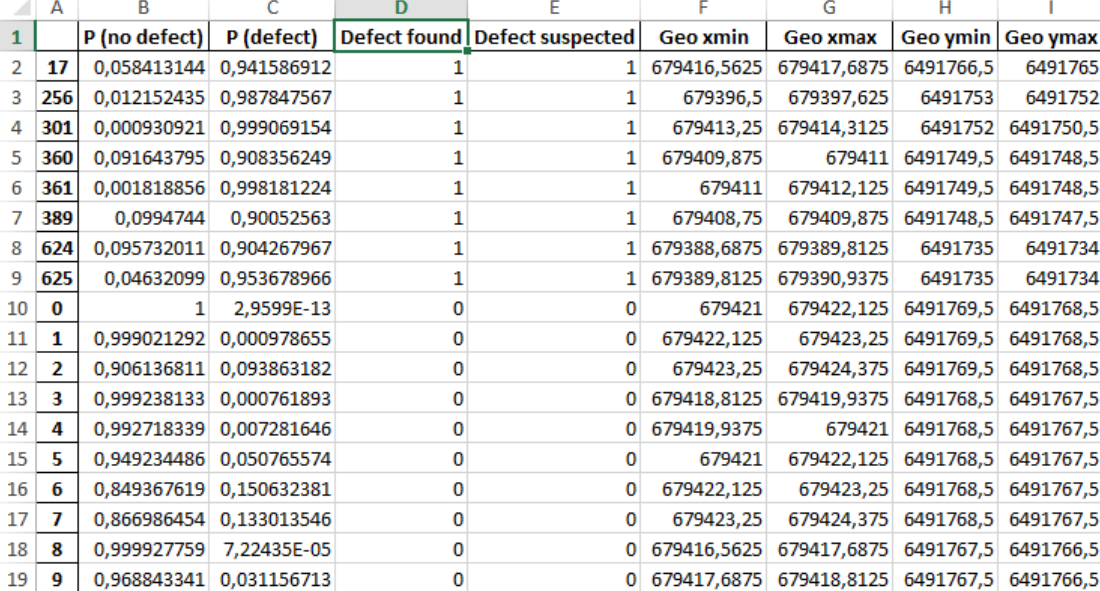
Figure 12. Example report concerning potential pavement defects generated by the nnapply